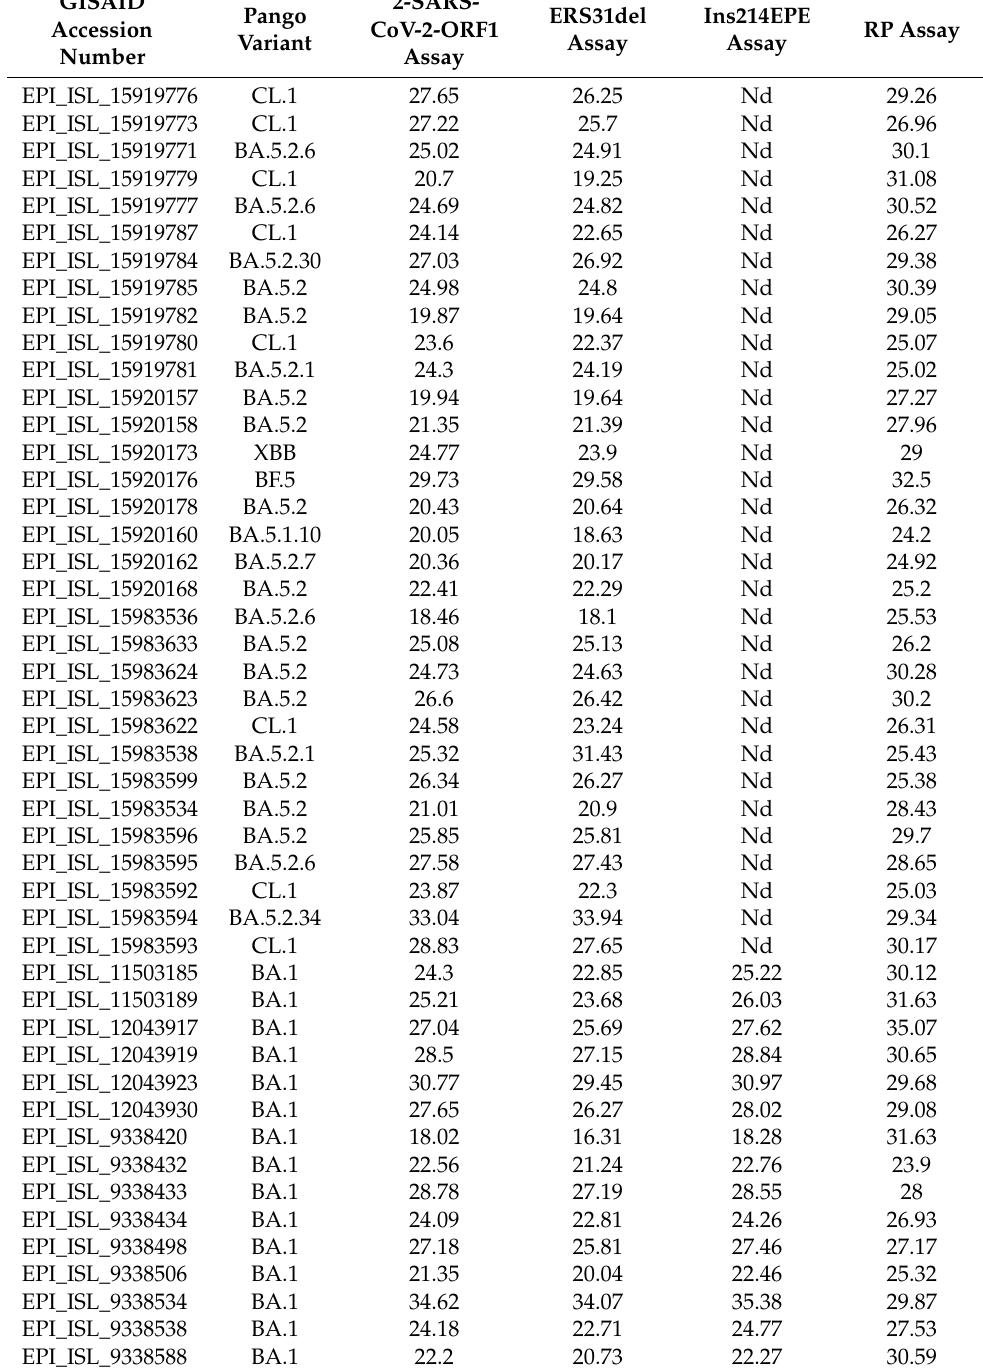
Table A1. Test of the multiplex RT-qPCR assay specificity on 96 samples containing variants